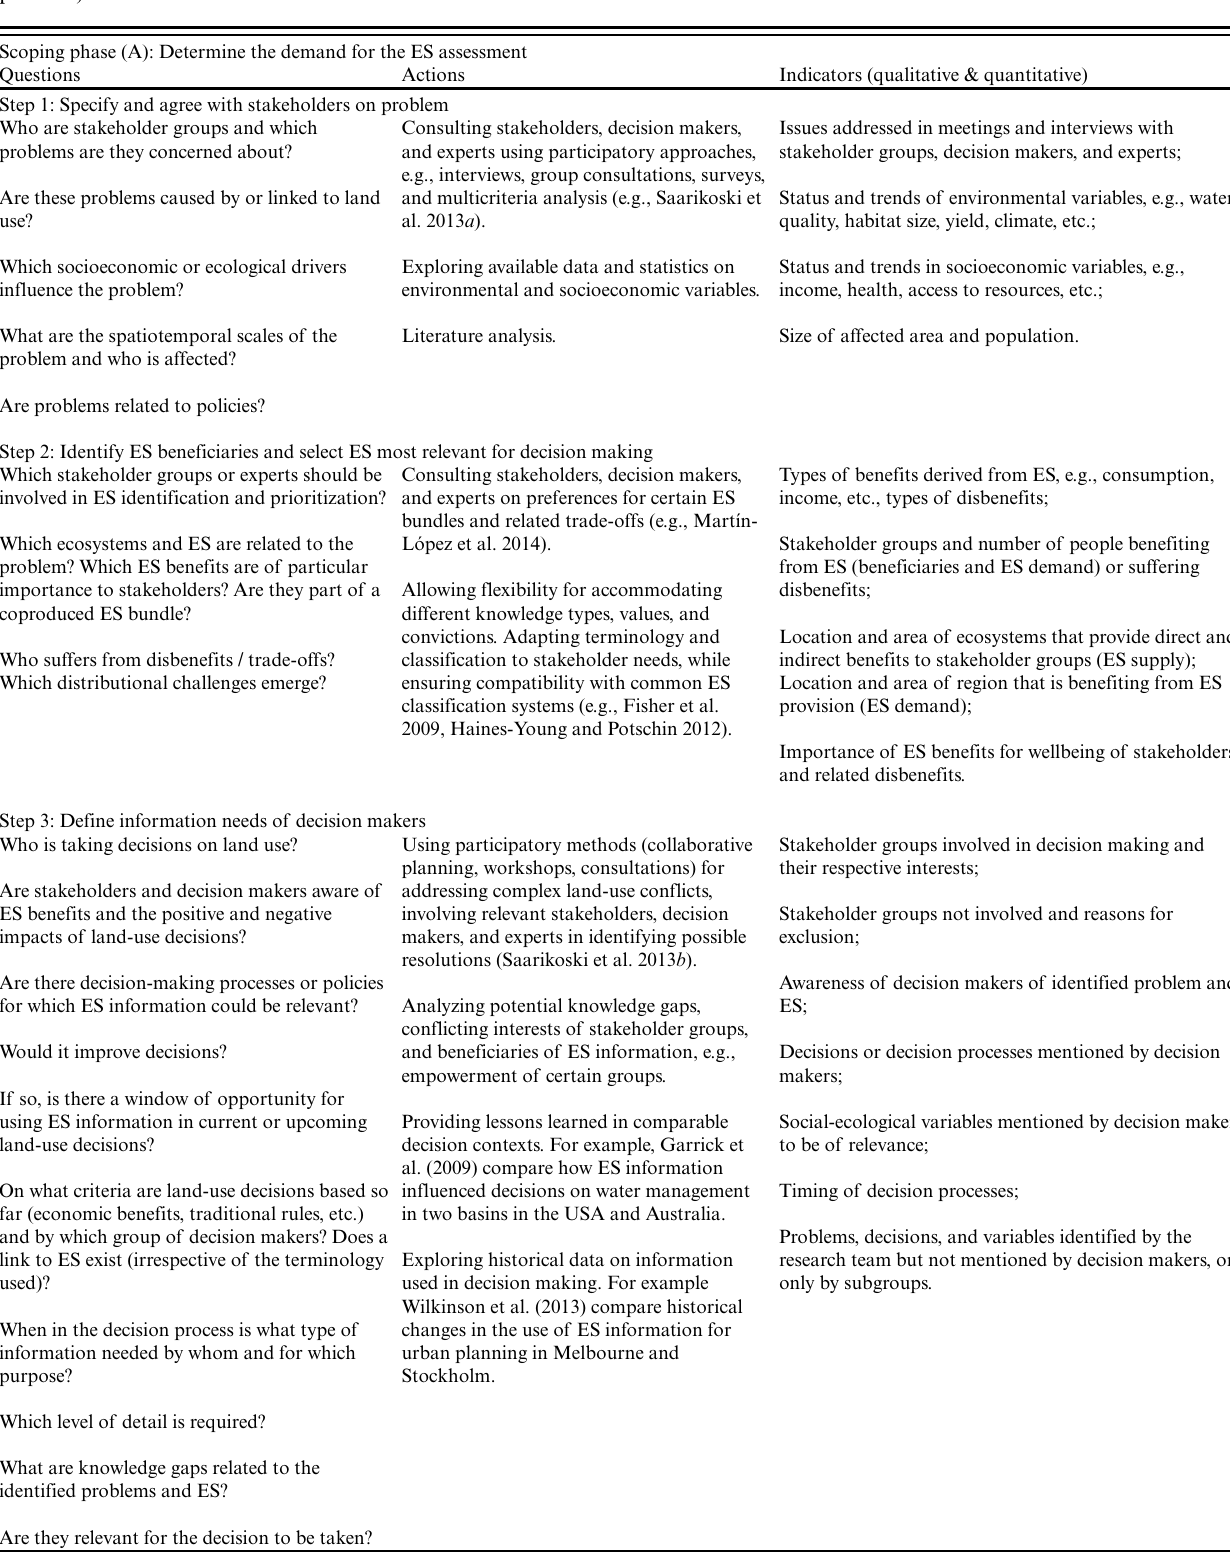
Table 1 . Examples of questions, actions, and indicators for determining the demand for the ecosystem services (ES) assessment (Scoping phase